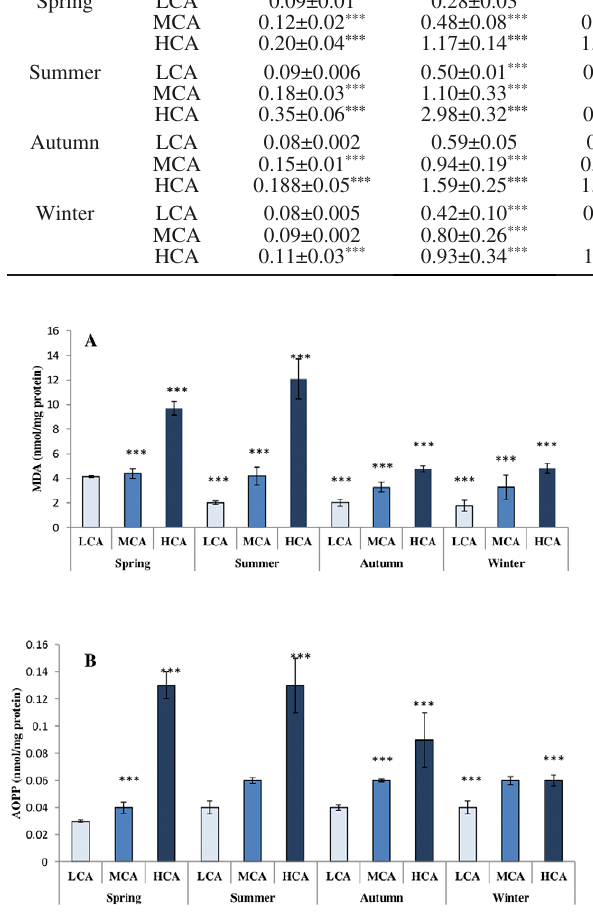
Fig. 2. – Seasonal variation of (A) malondhyaldehide (MDA) and (B) advanced oxidation of proteins product (AOPP) levels in the di- gestive gland of R. decussatus sampled from three coastal Tunisian lagoons: Ghar el Melh (LCA), the North Lake (MCA) and the South Lake (HCA). Results are presented by mean±SD. Significant dif- ferences are determined at 0.05 using two-way ANOVA: *p<0.05, **p<0.01;